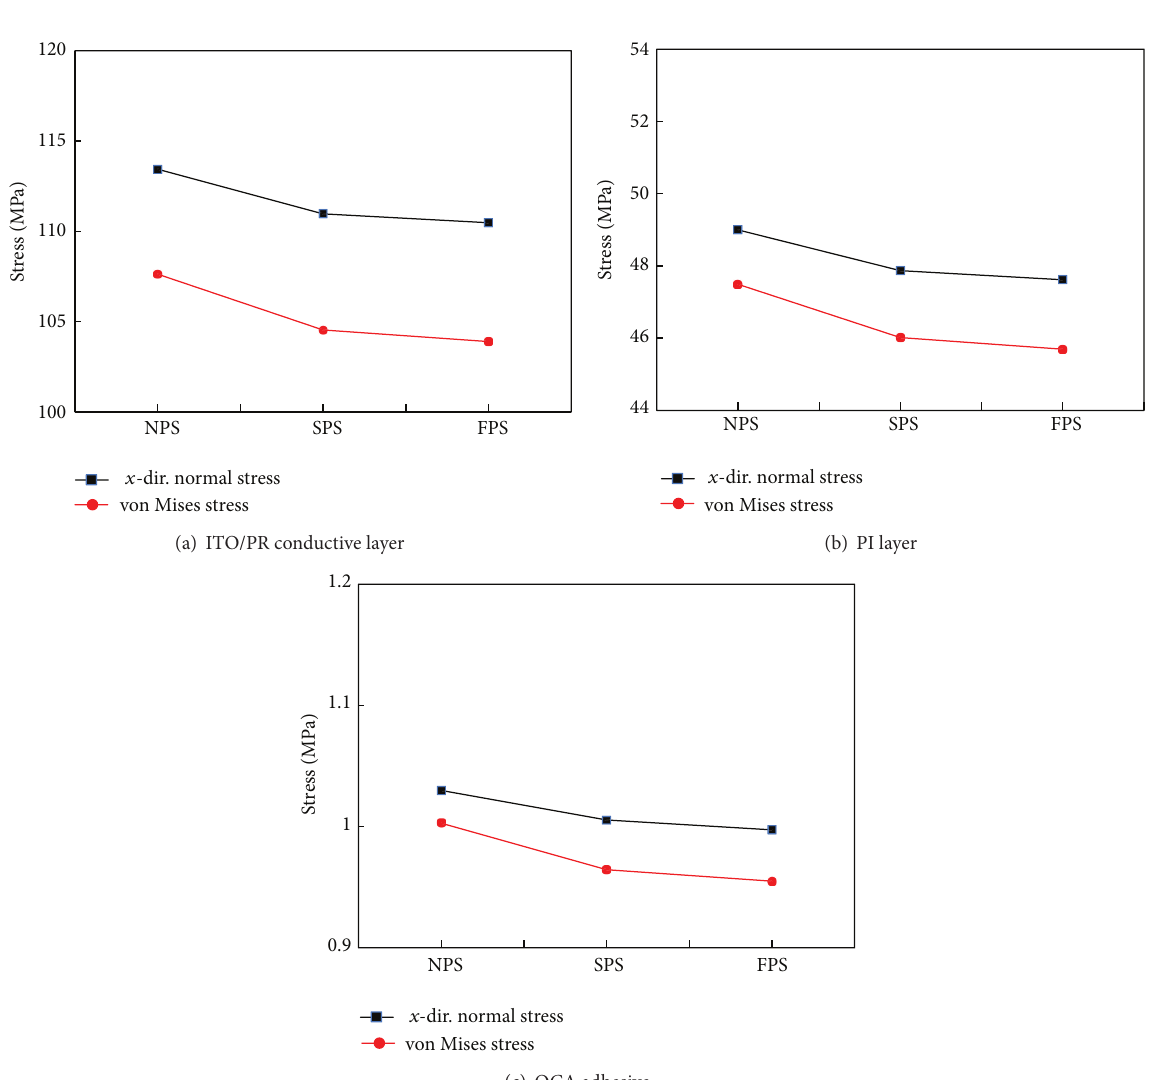
Figure 9: Bending stresses at the ITO/PR, PI, and OCA components associated with the three protection structure